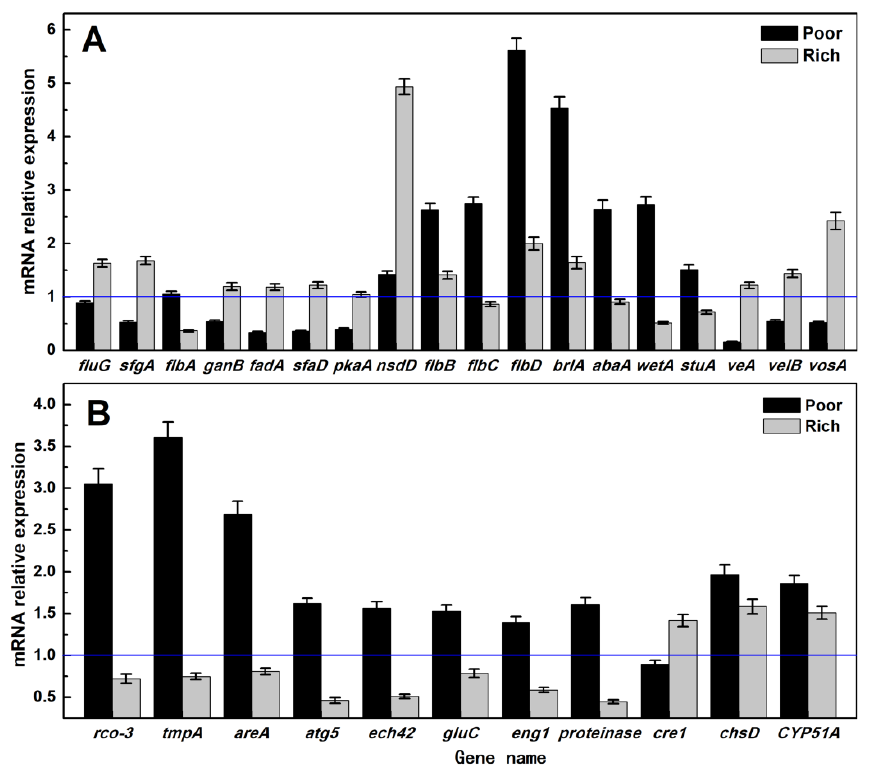
Figure 4. Different nutritional conditions effect on the genes involving in condition of A . cinnamomea . ( A ): changes in the expression of genes related to asexual sporulation signal pathway mediated by A. cinnamomea FluG; ( B ): changes in the expression of other genes related to asexual sporulation of A. cinnamomea matched with the local protein database; A. cinnamomea 18S rRNA gene was taken as the internal reference, and mycelium of control group was taken as CK.